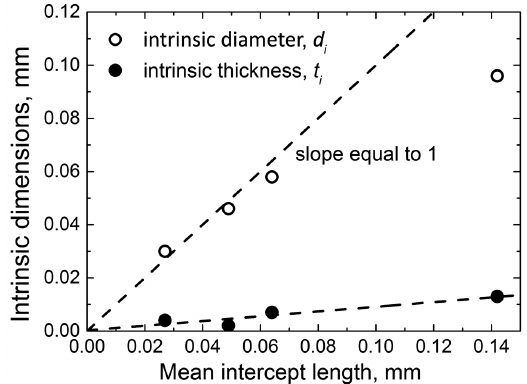
Figure 5. Martensite intrinsic thickness and diameter typical of the initial transformation burst in the Fe-31wt%Ni-0.02wt%C alloy as a function of the austenite grain intercept. The temperatures of the bursts are in the interval 212-222 K. Data from Table 3. The straight lines indicate a linear dependence of both r